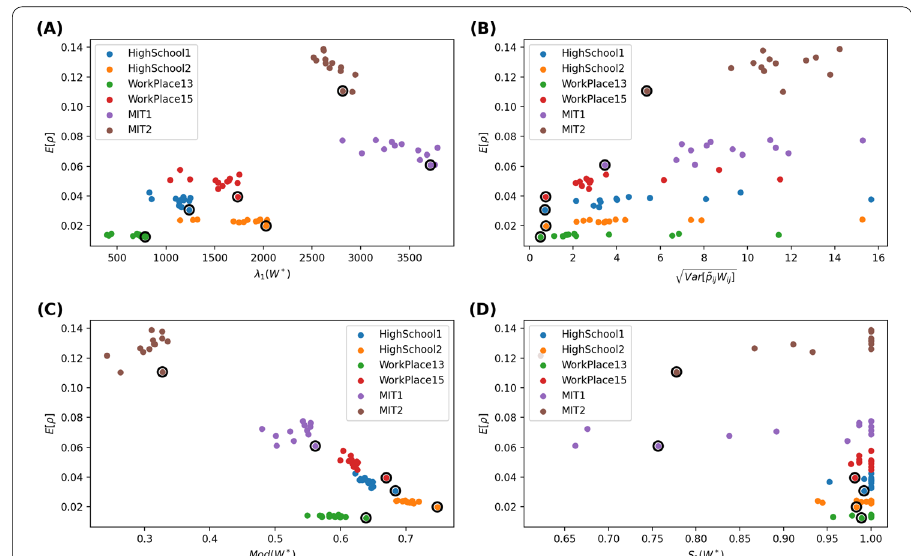
Fig. 4 Scatter plot of the average prevalence E [ ρ ] versus the largest eigenvalue (cid:31) 1 ( W ∗ ) of the aggregated pruned network ( A ), the standard deviation (cid:31) Var [˜ p ij w ij ] of the average number of contacts removed from a node pair ( B ) the modularity Mod ( W ∗ ) ( C ) and the relative size of the largest connected component of the aggregated pruned network ( D ), respectively. A fraction φ = 10% of the contacts are removed. The recovery rate is γ = 1.22 ∗ 10 − 6 per step, approximately 10% per day. The results obtained with 1/link weight strategy are circled